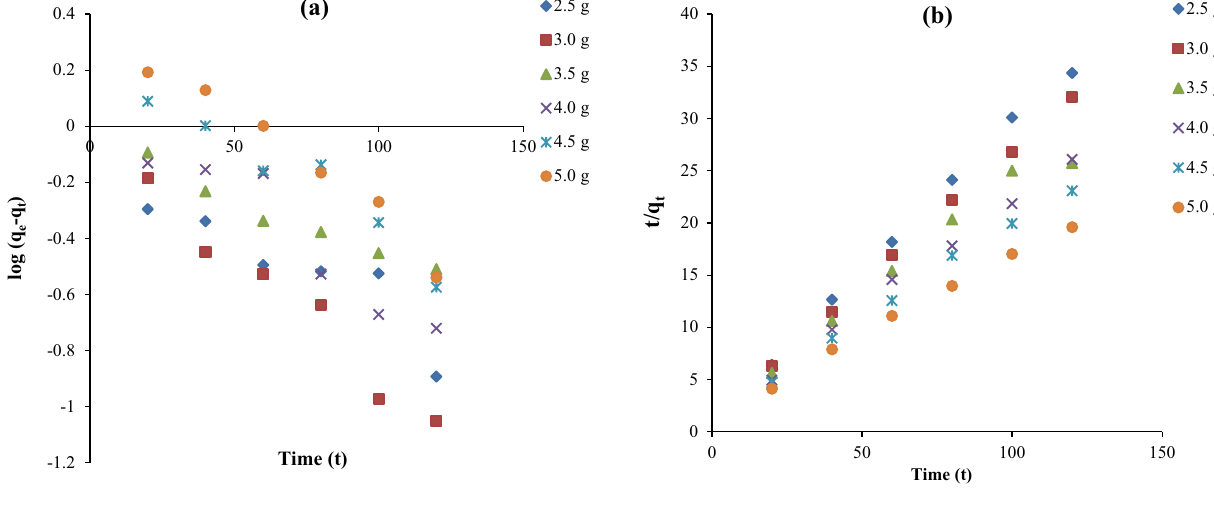
Fig. 7 Role of time a pseudo-first-order kinetic plots and b pseudo-second-order kinetic plots Table 3 Pseudo-first-order and pseudo-second-order kinetic constants for sorption of lead (Pb 2+ ) onto bagasse